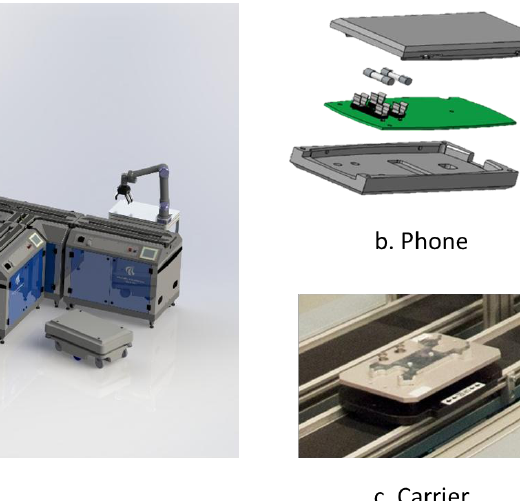
Figure 4. Overview of the Smart Production